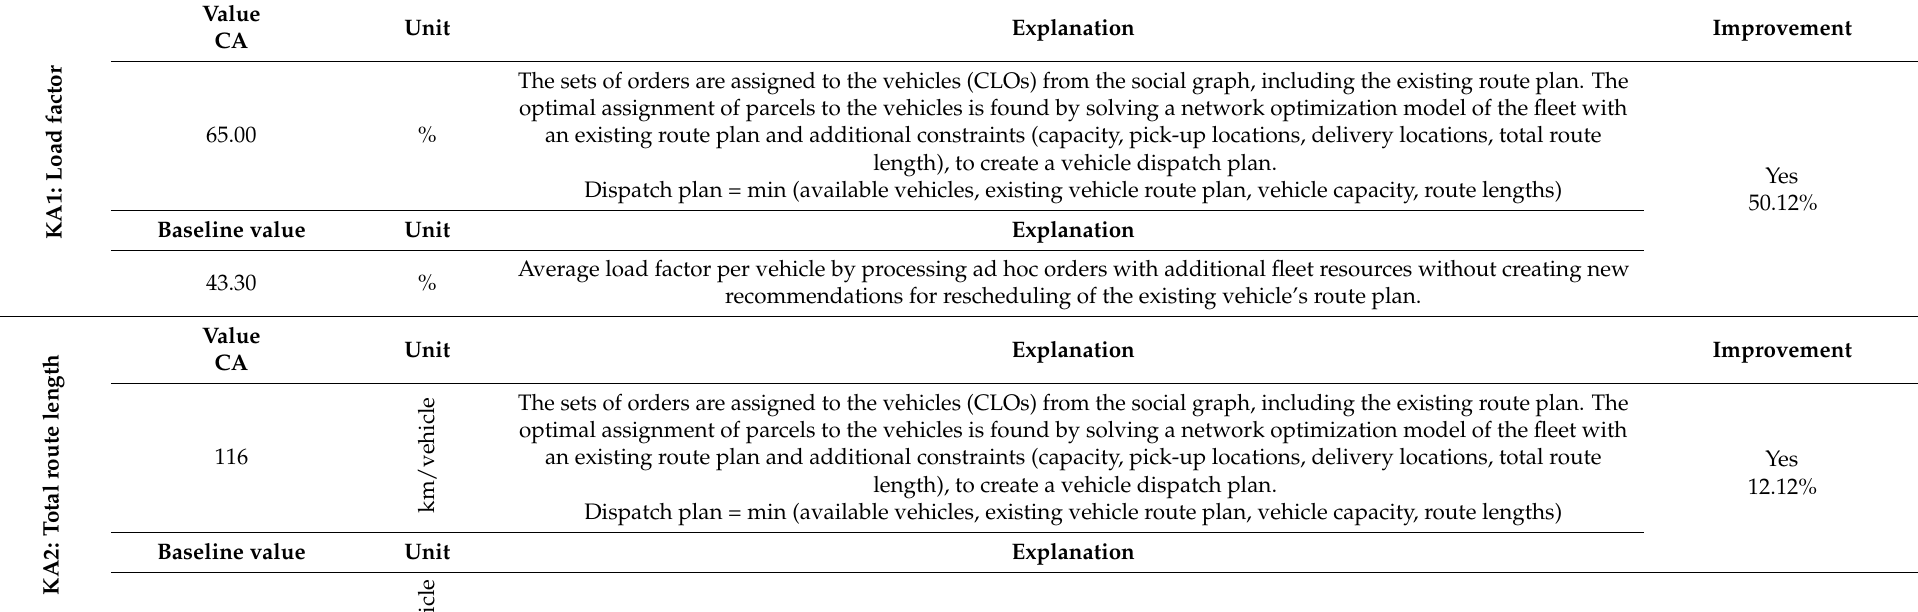
Table 3. Results on measured KPIs